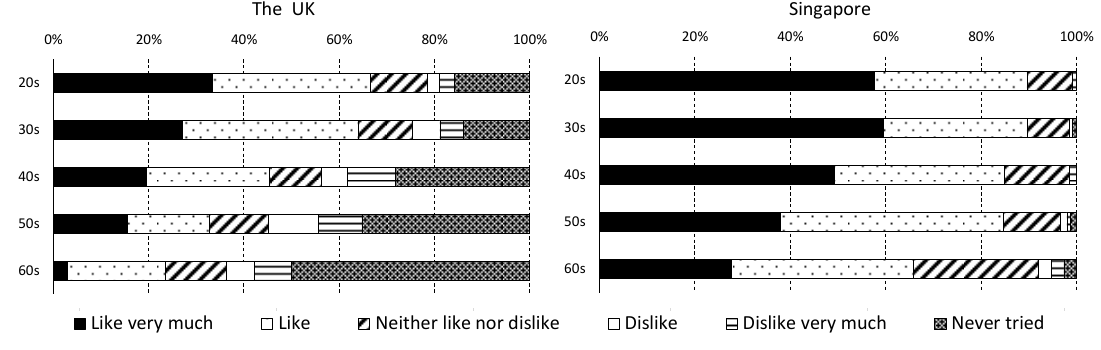
Figure 1. Answers to the question “Do you like sushi?”.